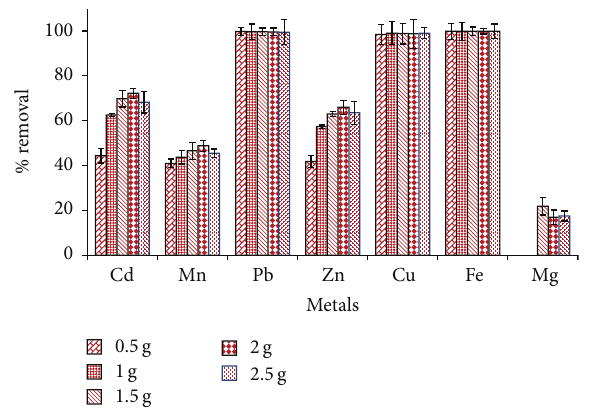
Figure 17: Percentage removal of metals from wastewater using MNS.